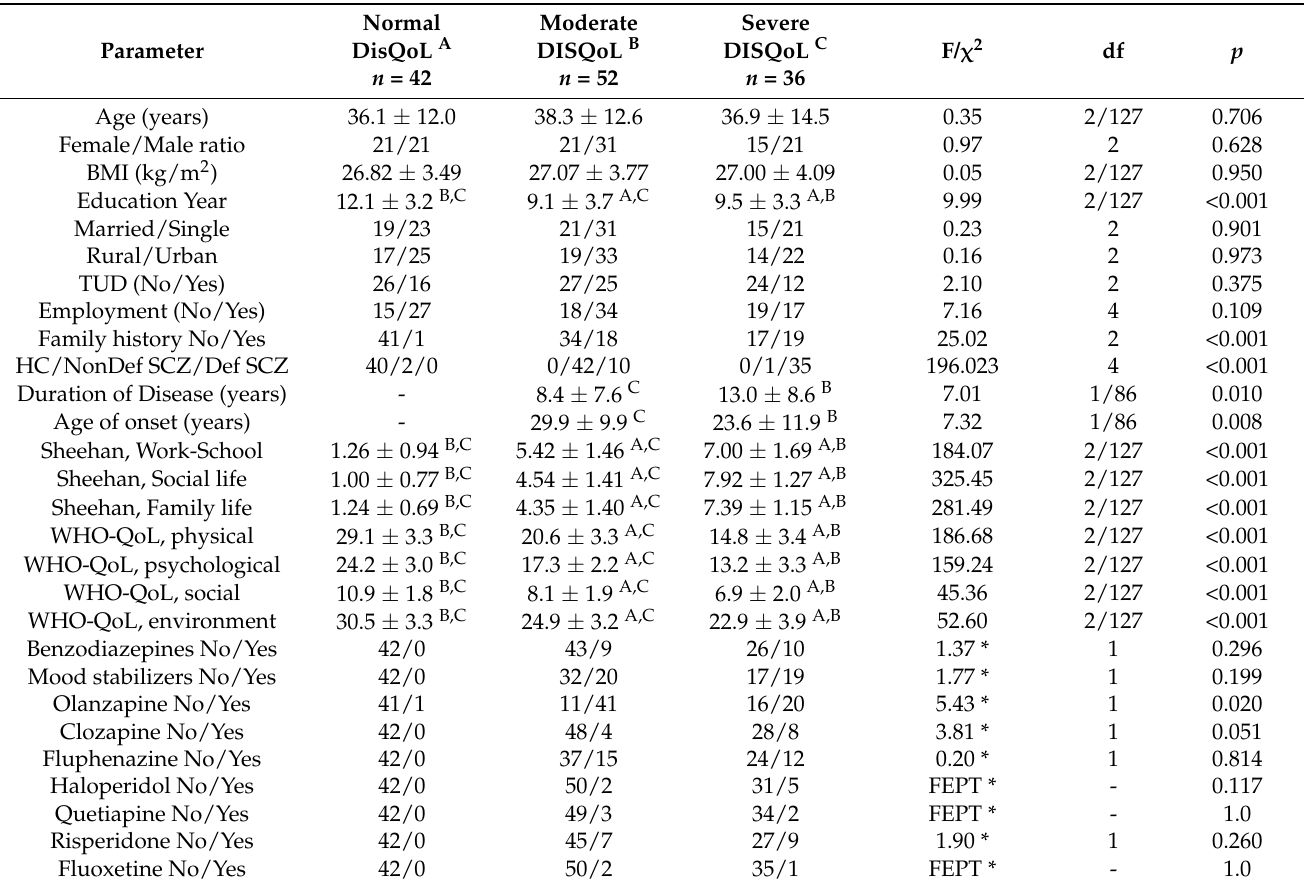
Table 1. Socio-demographic and clinical variables in healthy controls and schizophrenia patients divided into subjects with severe disabilities and low quality of life (severe DisQoL), moderate changes in disabilities and DisQoL (moderate DisQoL) and those with normal DisQoL values (nor- mal